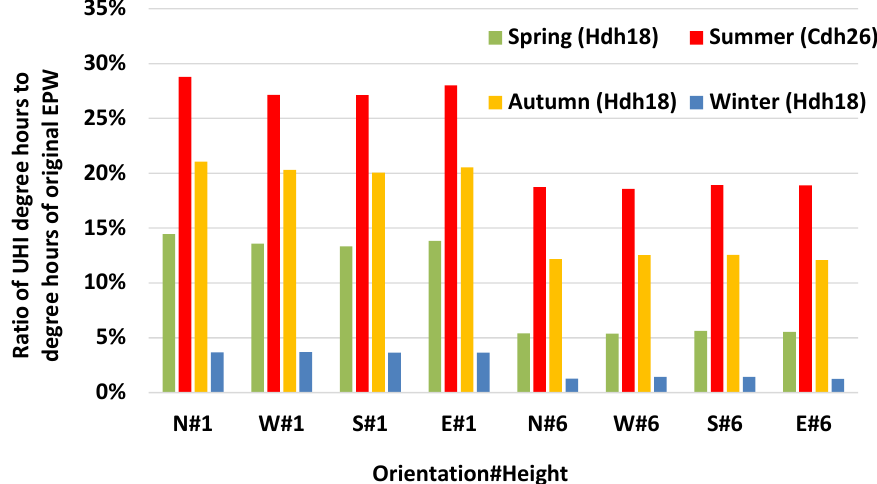
Figure 17. Ratio of UHI degree-hours to degree hours of original EPW.